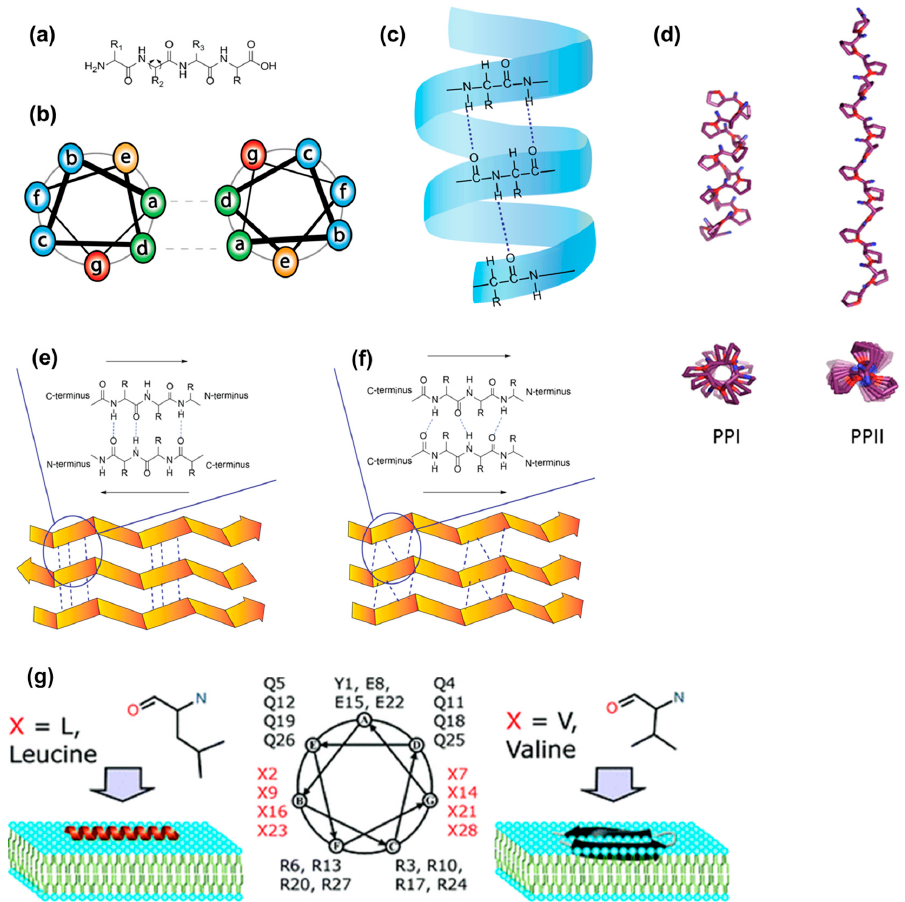
Figure 5. Schematic representation of ( a ) primary peptide sequence with dihedral angles; ( b ) heptad units: ( abcdefg ) n where the a and d (green) are hydrophobic amino acids, e and g (orange and red) are oppositely charged amino acid residues, and b , c and f (blue) represent the solvent-exposed amino acids; ( c ) α -helix structure indicating hydrogen bonding; ( d ) Structures of PPI and PPII reprinted with permission from reference [113] (Copyright © 2017, American Chemical Society); schematic representation of ( e ) anti-parallel and ( f ) parallel β -sheets found in proteins and synthetic peptides. ( g ) Schematic representation α -helical or β -sheet folds that form upon the interaction of CPPs with membranes, where even small changes in the primary sequence result in different folding behavior, reproduced with permission from reference [112] (Copyright © 2010, American Chemical Society).